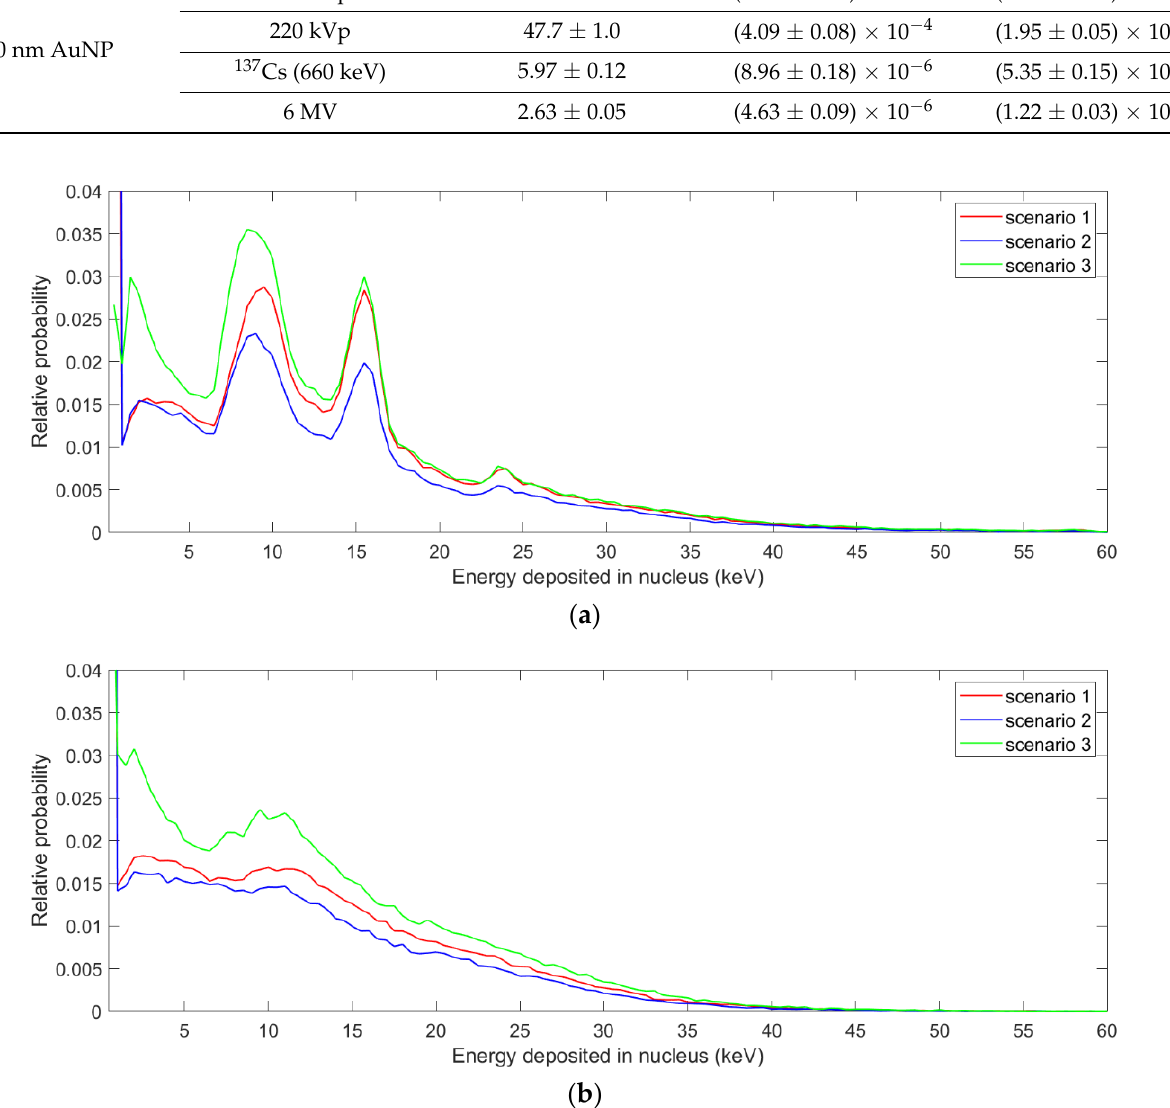
Figure 3. The distribution of energy deposited in the nucleus from one photon ionizing event for AGuIXs ( a ) and AuNPs ( b ), irradiated with 250 kVp and 220 kVp beams,